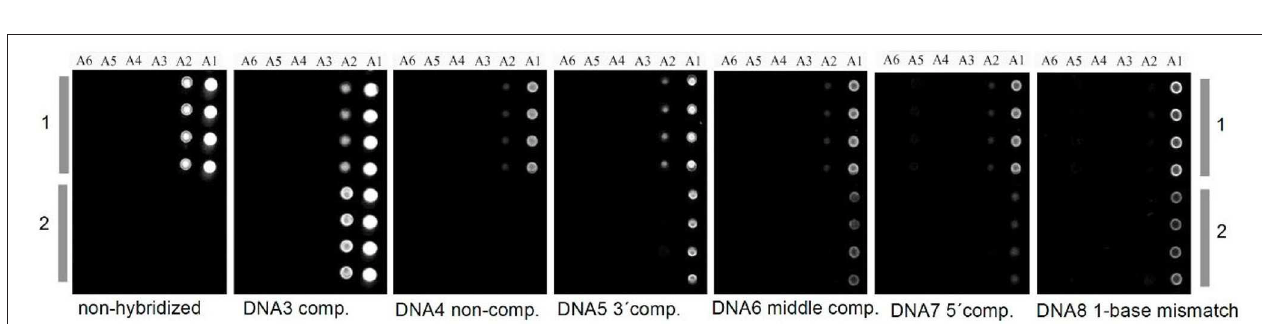
FIGURE 11 | Carboxymethyl cellulose decorated cellulose thin films in DNA microarrays before and after hybridization (copyright Elsevier 2015) (Kargl et al.,